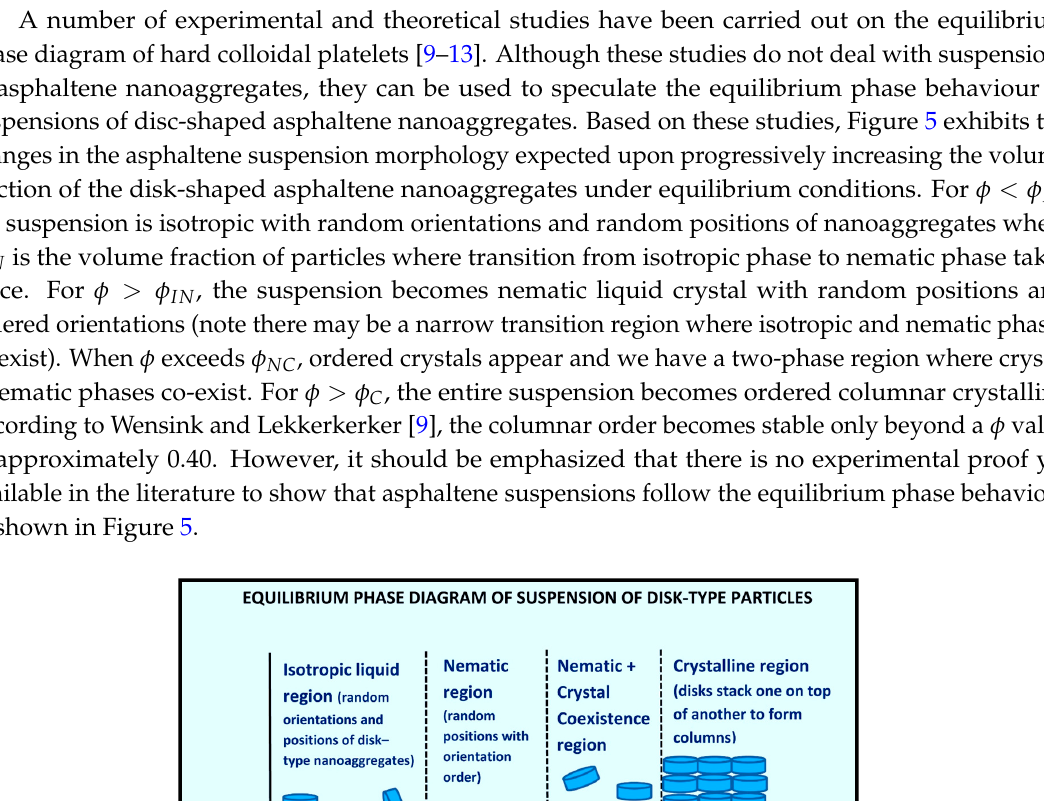
Figure 5. Changes in suspension morphology expected with increase in φ under equilibrium conditions.